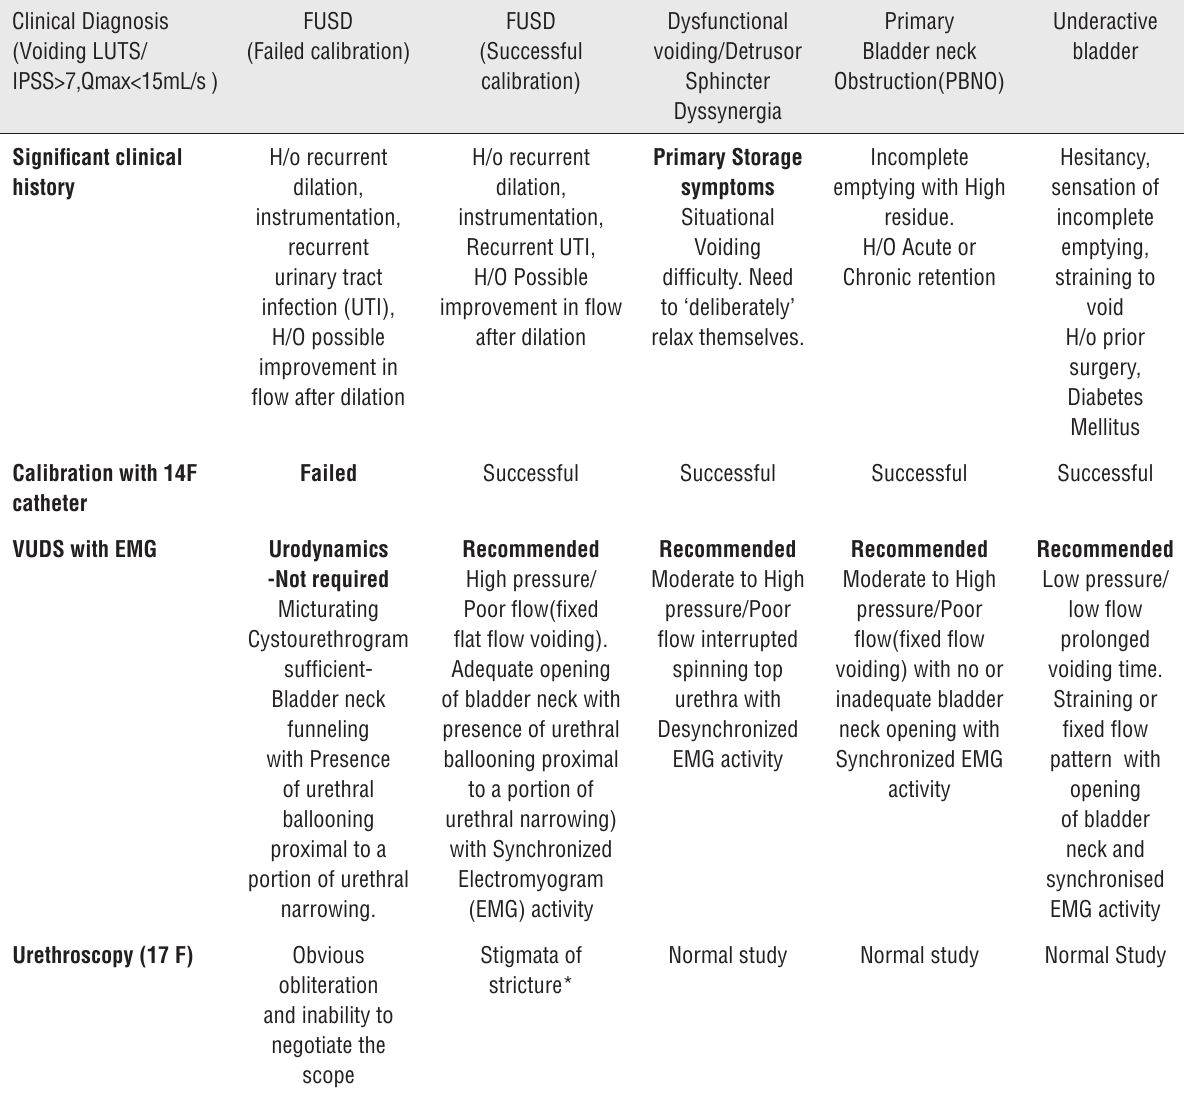
Table 1 - Differential Diagnosis of Female urethral stricture